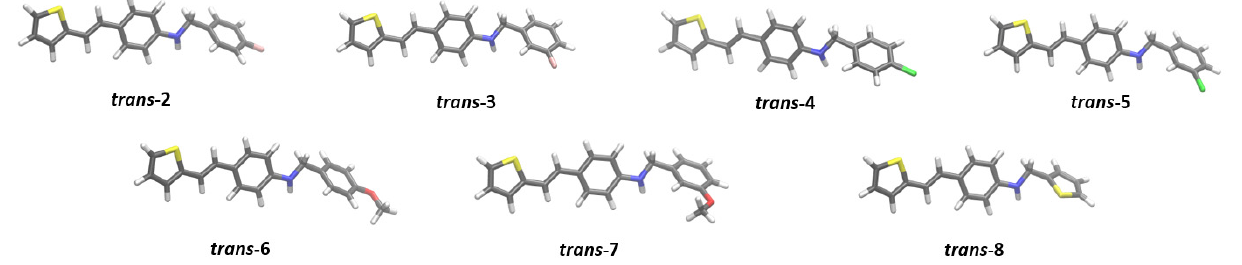
Table 2. Measured and calculated λ max values for trans -styryl-thiophene benzylamines, along with main assignments. (CPCM)TD-CAM-B3LYP/6–31++G(d) (ACN), with geometries optimized at the M06-2X/6-31G(d) level of theory. The highest occupied and lowest unoccupied molecular orbital are denoted by H and L, respectively.